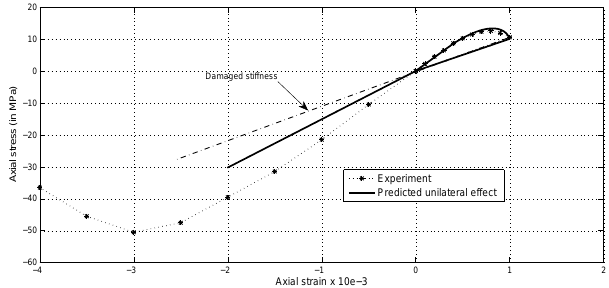
Figure 6. Unilateral effect in tension-compression loading.